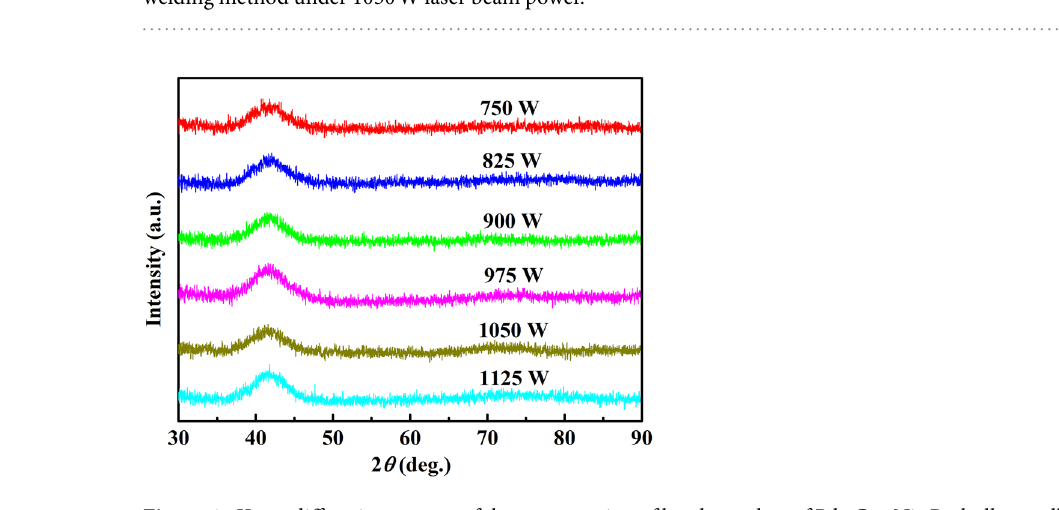
Figure 4. X-ray diffraction pattern of the cross-section of bead-on-plate of Pd 43 Cu 27 Ni 10 P 20 bulk metallic glass using the pulsed laser welding method with various powers.